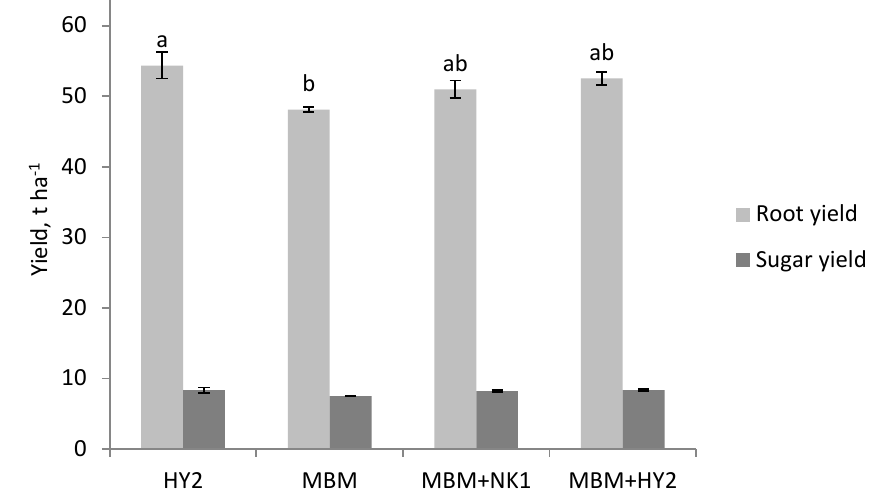
Fig. 1. Root yield and sugar yield of sugar beet by different fertilizations in 2008. (Error bars: ± standard error. Different lowercase letters above columns indicate significant ( p =0,05) differences between the